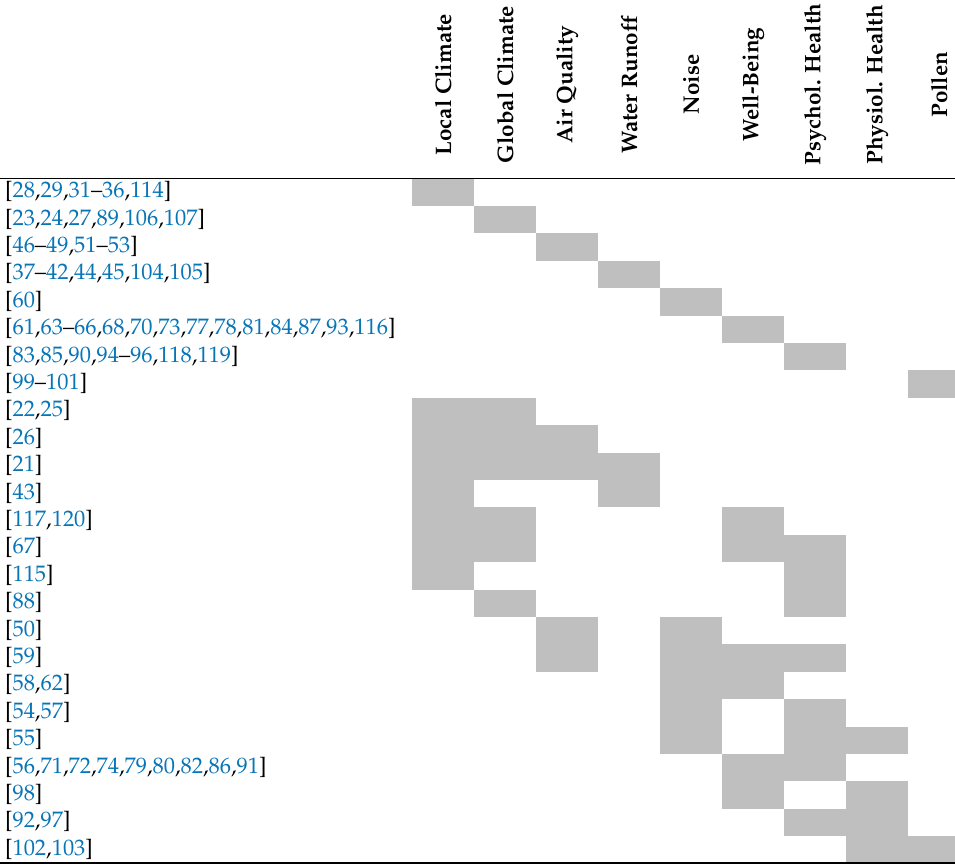
Table A3. Classification of papers reviewed per topic (shaded